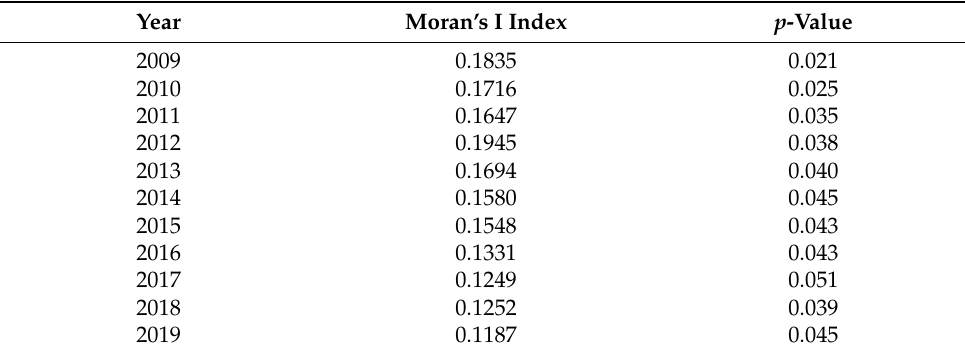
Table 6. The results of Global Moran’s I index for ACEP from 2009 to